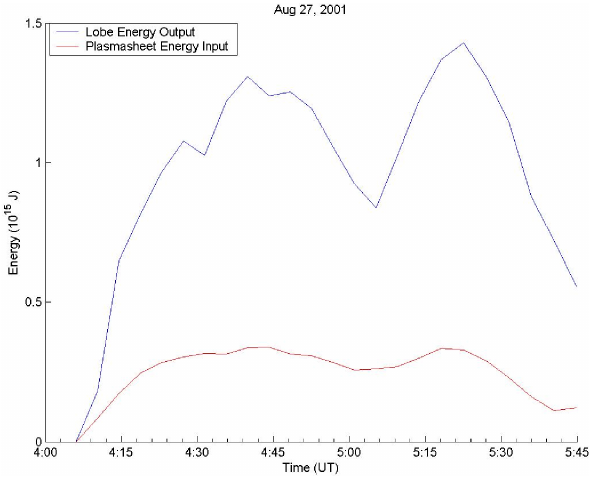
Fig. 10. The absolute amount of decrease in the lobes after the 27 August 2001 substorm onset and the absolute amount of increase of magnetic energy in the plasma sheet is shown. The ratio of the two is about